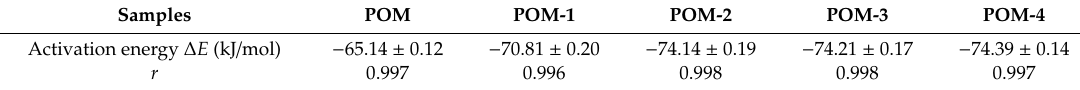
Table 6. Isothermal crystallization activation energy of POM / Ag nanocomposites.